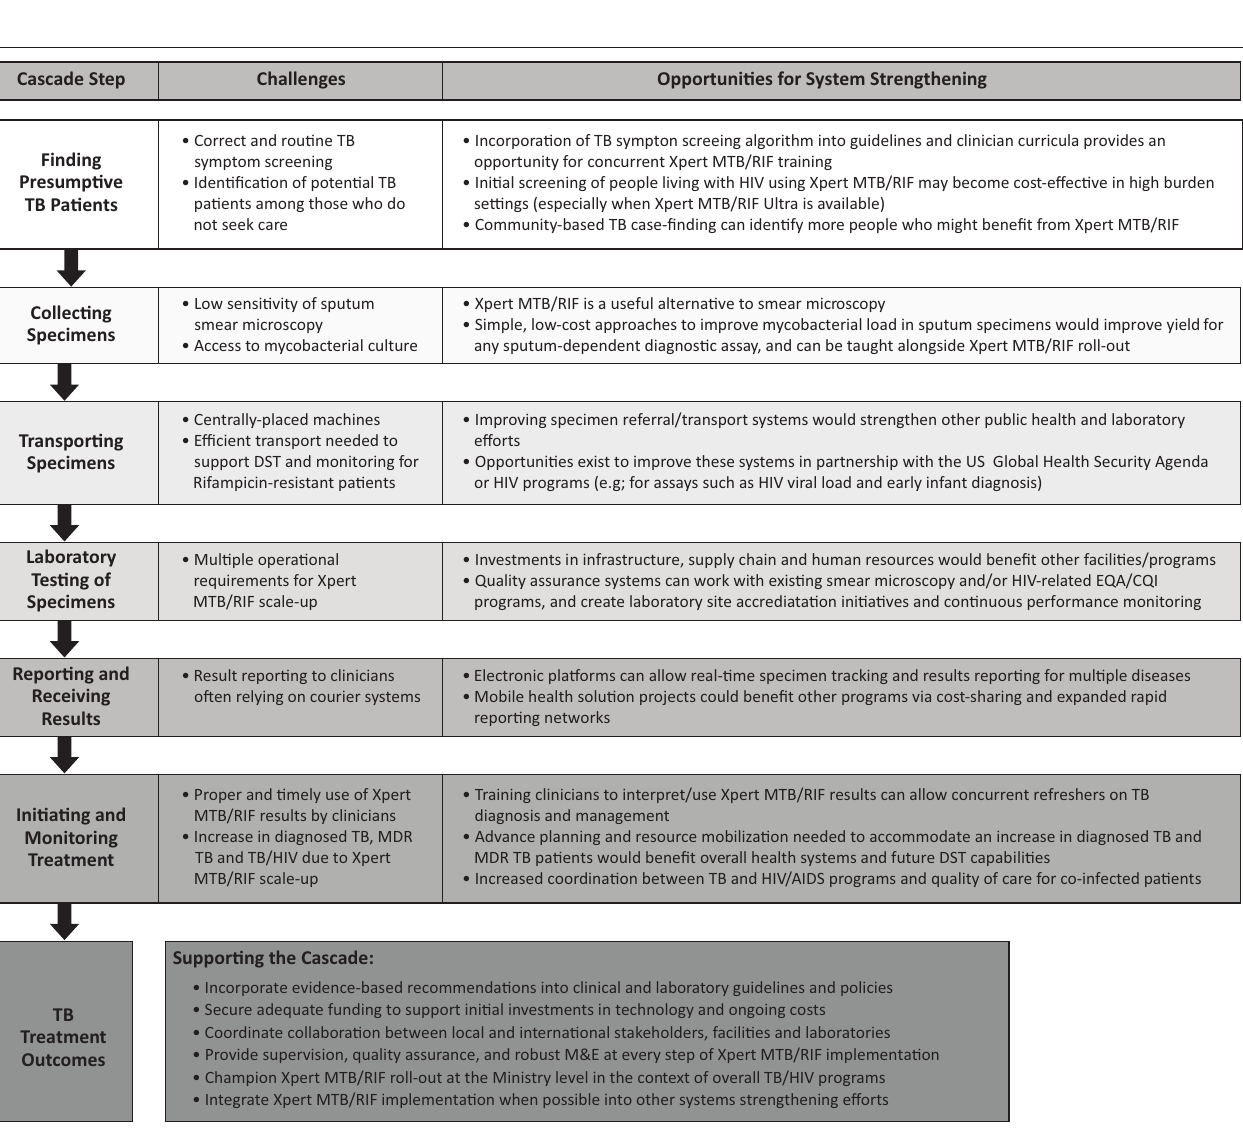
FIGURE 2: Summary of challenges and opportunities along the tuberculosis care